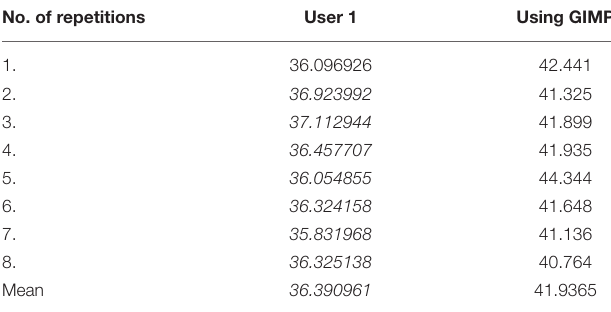
TABLE 4 | Bone area measurements obtained after classifying same image but at different times on TWS and GIMP (in %). No. of repetitions